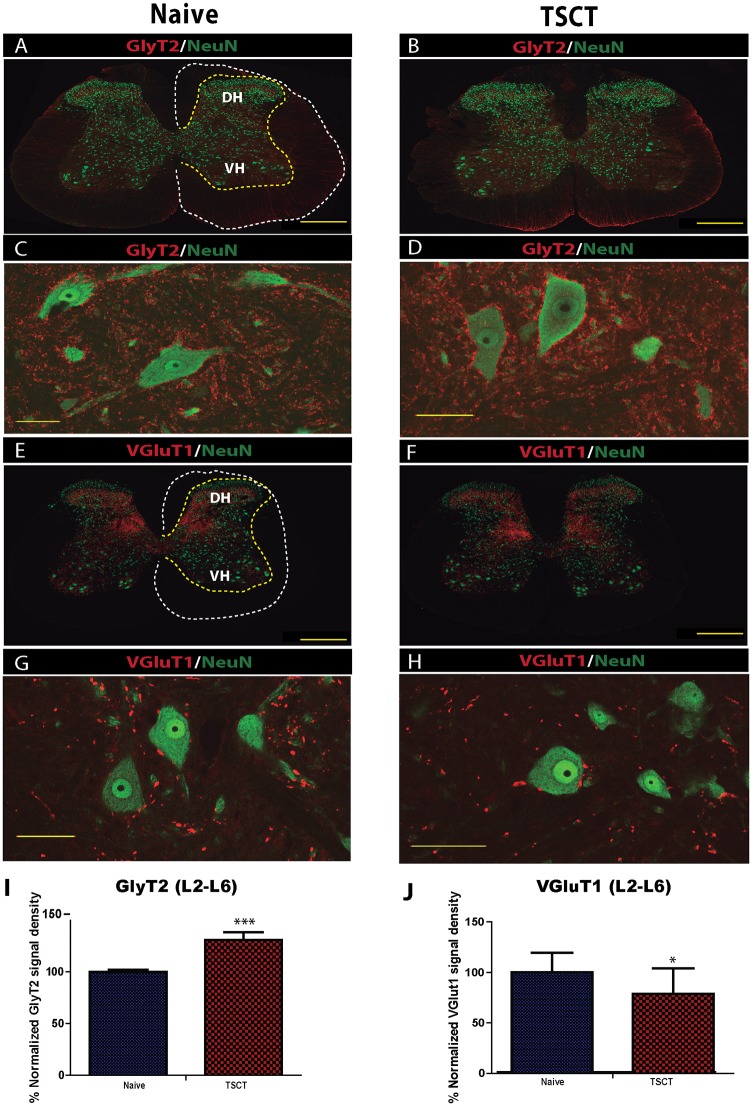
Quantitative and qualitative analysis of VGluT1 and GlyT2 expression in lumbar spinal cord (L2-L6) at 3 months post-spinal transection.
(A-H)- Transverse spinal cord sections taken from L2-L6 segments in naïve and spinally transected animals (3 months post-transection) and double-stained with GlyT2/NeuN or VGluT1/NeuN antibodies. Normally appearing distribution of neurons and GlyT2/VGluT1 staining pattern can be seen in both control and spinally transected animals. (I-J)- Statistical analysis of GlyT2 density signal and VGluT1 puncta in the ventral horn showed a significant increase in GlyT2 expression and a significant decrease in VGluT1 puncta in chronically transected animals (t-test *-p< 0.05; **-p< 0.01; scale bar: A, B, E, F: 500 μm; C, D, G, H: 80 μm).